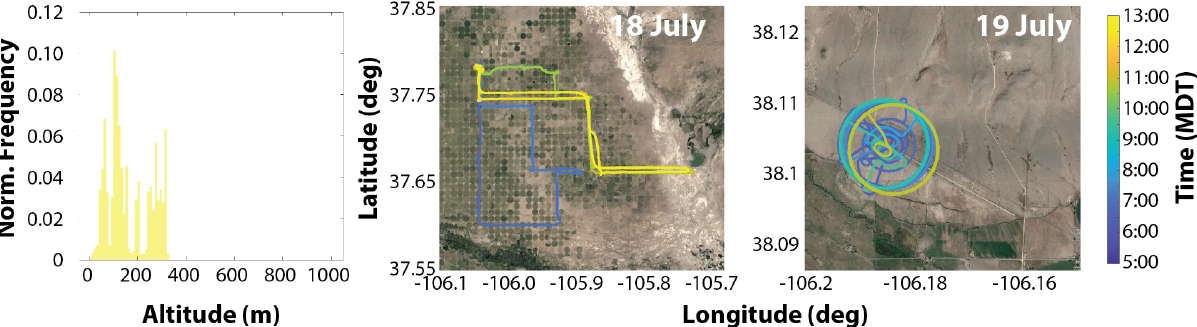
Figure 6. A histogram of altitudes covered during LAPSE-RATE by the TTwistor (left), along with the flight patterns covered by this aircraft during individual days of the campaign. See the map in Fig. 2 for additional details on flight locations. Map backgrounds are © Google Maps 2021 and downloaded through their